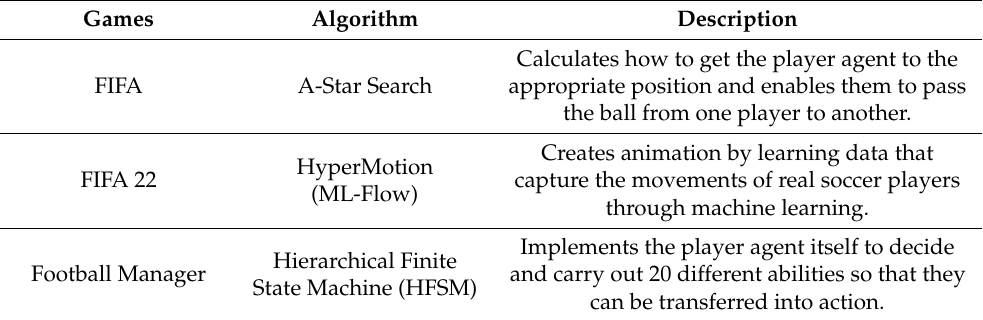
Table 1. Algorithms that are used in soccer-simulation games. Games Algorithm